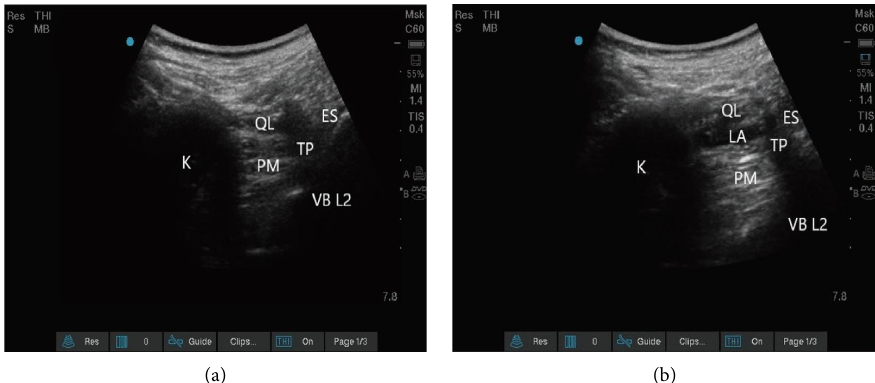
Figure 1: Ultrasonographic images of anterior QLB. (a) Ultrasound anatomical structure before block. (b) Spread of local anesthetic. K,